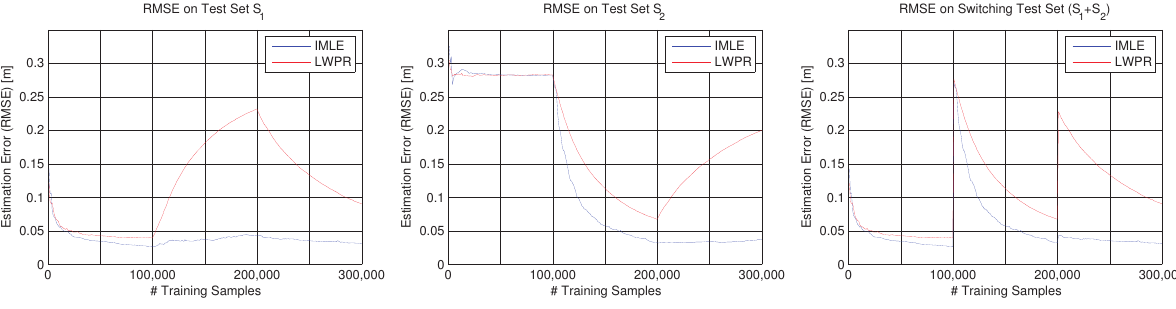
Figure 5. RMSE of the forward kinematic estimation (average of the three components of x ) during motor babbling with the iCub Simulator, using di(cid:636)erent test sets. Motor babbling is realized without the tool (until sample 100,000), then with the tool (until sample 200,000) and then again without the tool (until sample 300,000). Left: test set S 1 (no tool). Center: test set S 2 (28 cm stick tool). Right: test set is changed according to the tool used during the training, i.e. , first S 1 is used, then S 2 and finally S 1 again.